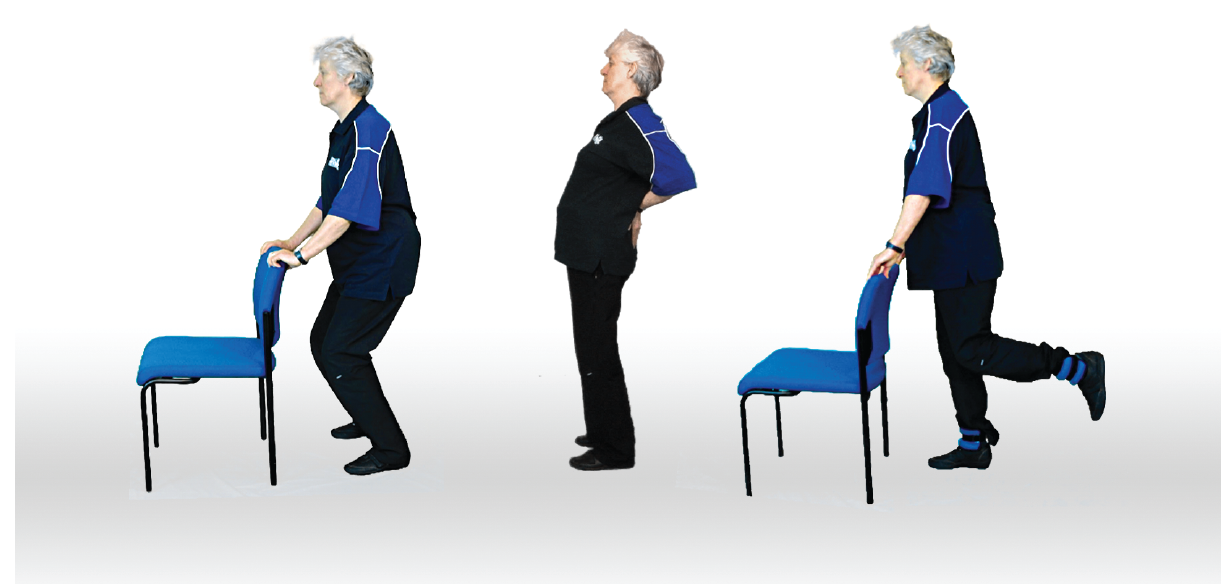
Figure 1. Screenshot of strength and balance exercises from the Otago Exercise Program